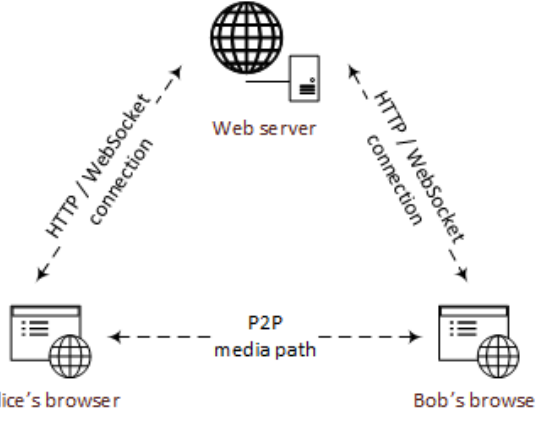
Figure 1. WebRTC triangle network